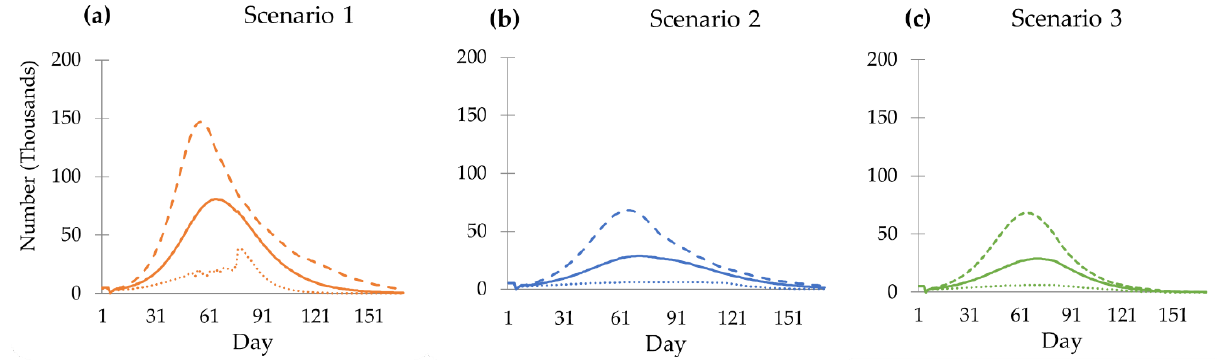
Figure 2. Daily reported incident cases of different scenarios from day 1 to day 170: ( a ) Scenario 1, no booster dose; ( b ) Scenario 2, viral vector vaccine as booster dose; ( c ) Scenario 3, mRNA vaccine as a booster dose. The solid line shows the mean of the outcome. The dashed line shows the 97.5th percentile of the outcome. The dotted line shows the 2.5th percentile of the outcome.